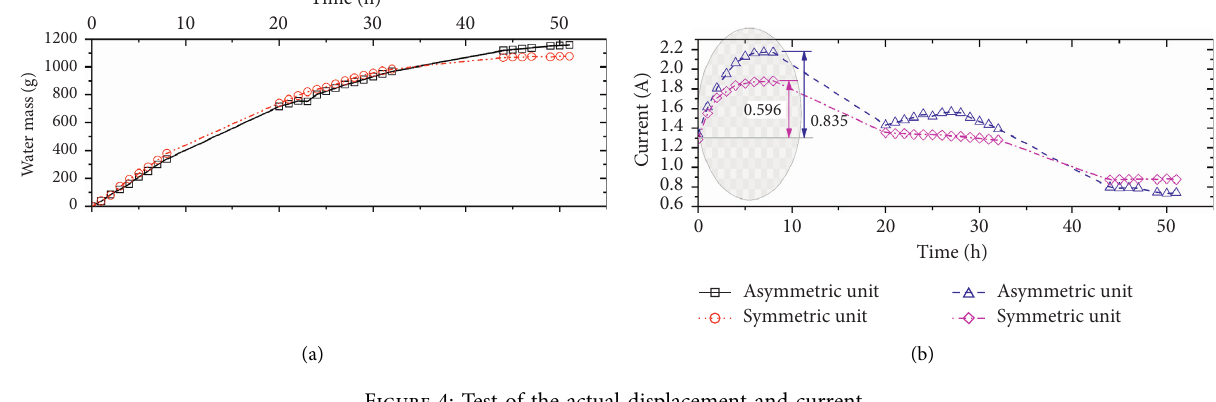
Figure 4: Test of the actual displacement and current.